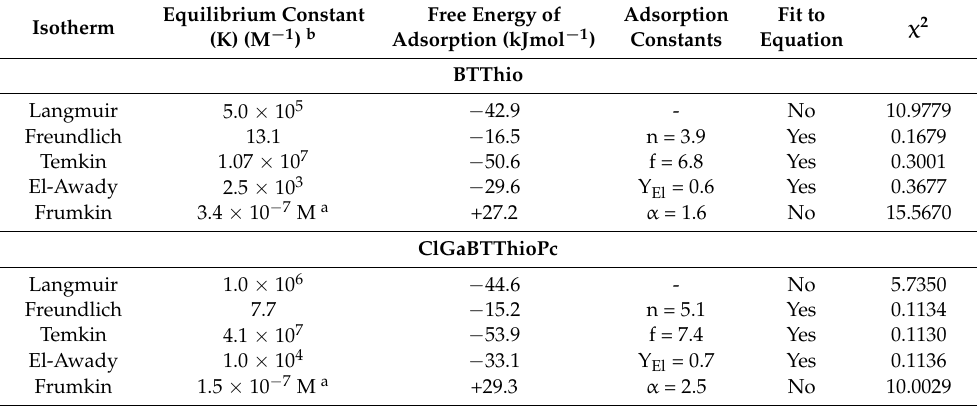
a Different units of equilibrium constants, b K and